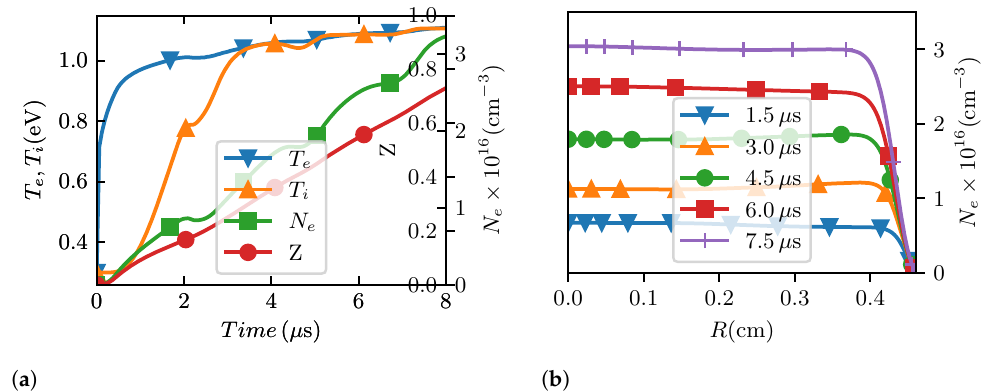
Figure 5. Temporal evolution of axial plasma parameters in the tube ( a ), radial profiles of electron density for several moments of time ( b ) for parameters of the experiment and initial nitrogen pressure P =